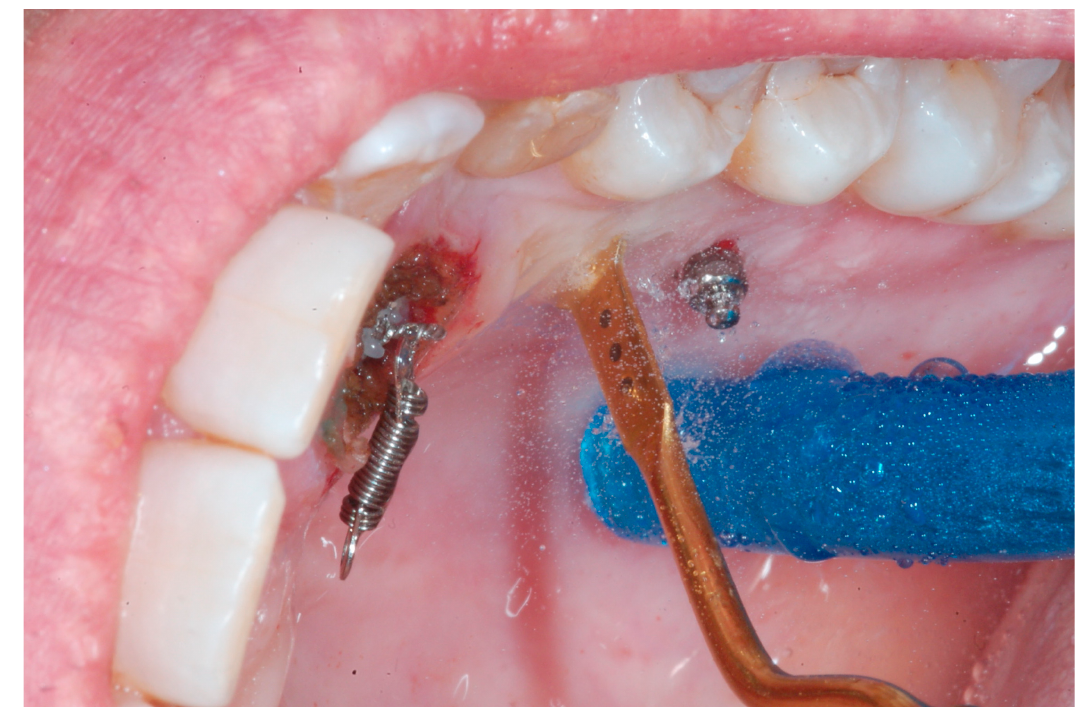
Figure 12. A piezocision cut carried out along the eruption path of the canine in order to reduce bone resistance.